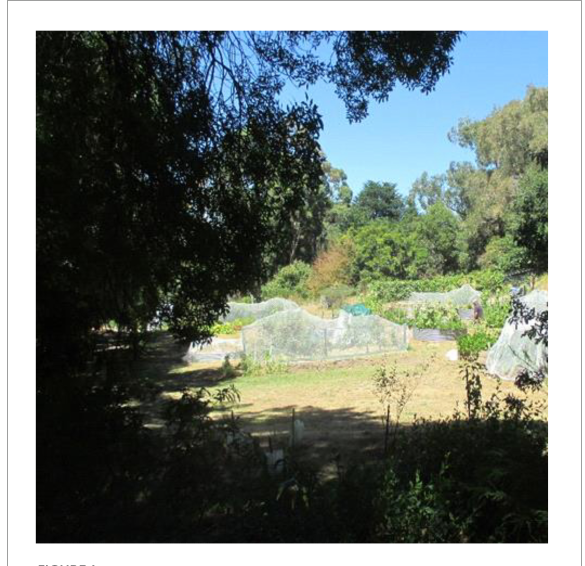
FIGURE1 A shared space for humans and wildlife.